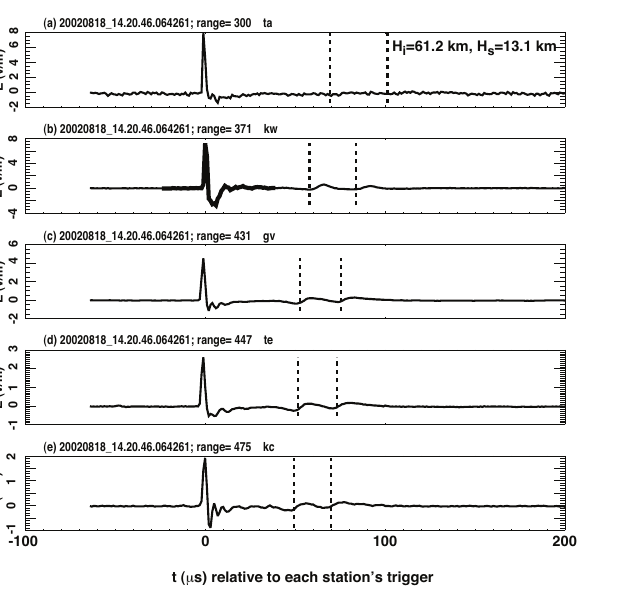
Fig. 2. Expanded view of ionospheric echoes from the more dis- tant 4 stations in Fig. 1. The light curves are the various sta- tions’ recorded data. The heavy curves are the modeled ionospheric echoes using a low-pass filter. Each modeled curve is individually optimized by fitting its own optimum H i , H s (see text). The range and station designator are indicated near each station’s data and